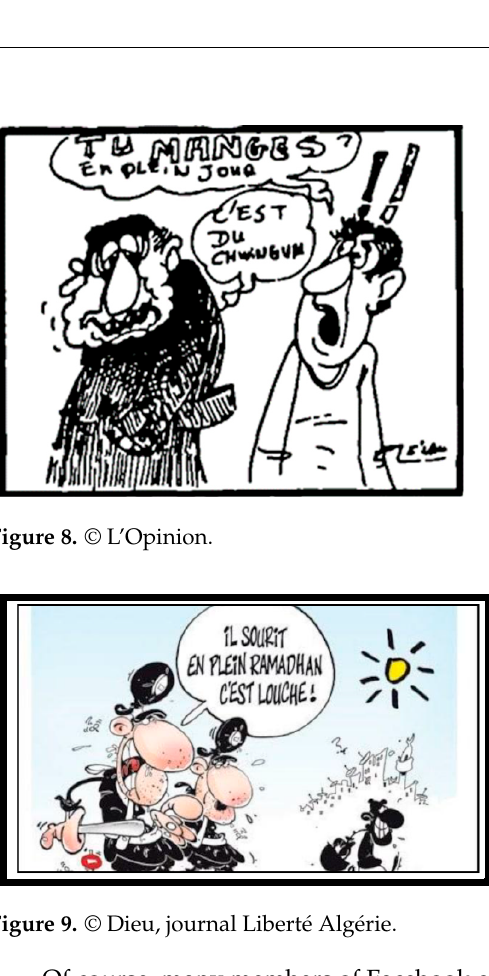
Figure 9. © Dieu, journal Liberté Algérie.